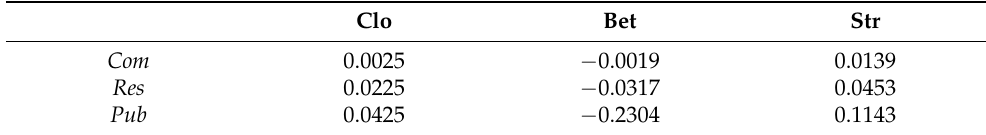
Table 6. Influence coefficient of LUI on SC. Clo Bet